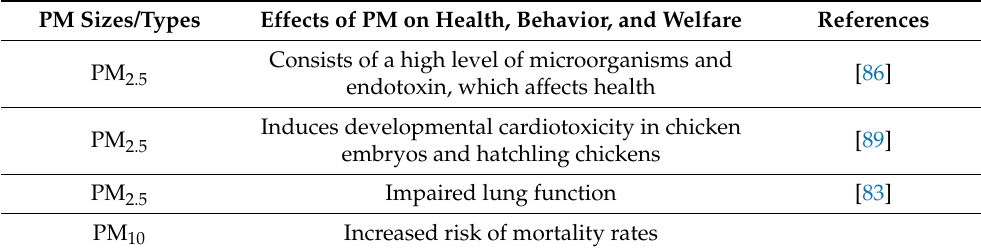
Table 6. Effects of various PM sizes or types on health, behavior, and welfare of